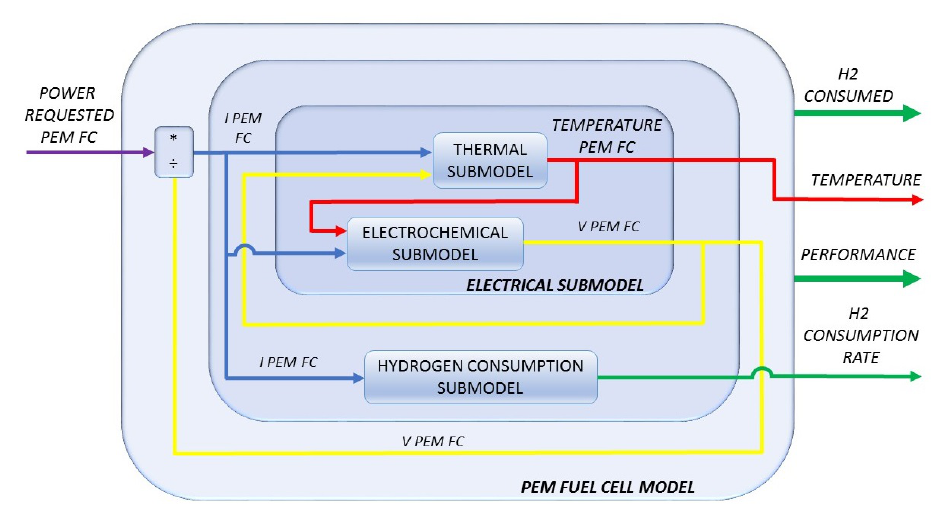
Figure 5. Block diagram of sub-models for a PEM fuel